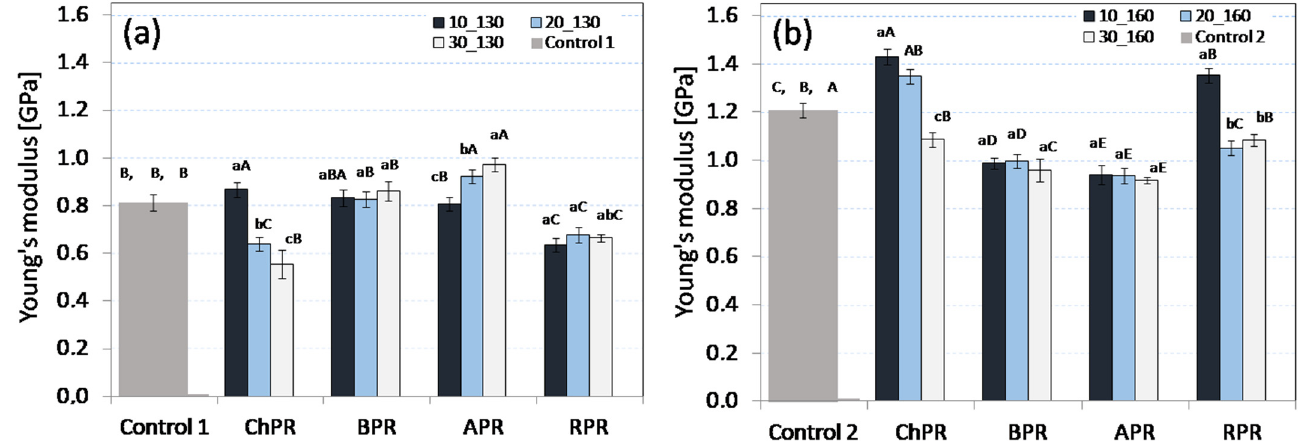
Figure 3. Average Young’s modulus, for all biocomposites with each share of used pomace: ( a ) sample produced at temperature of 130 °C, ( b ) sample produced at temperature of 160 °C.